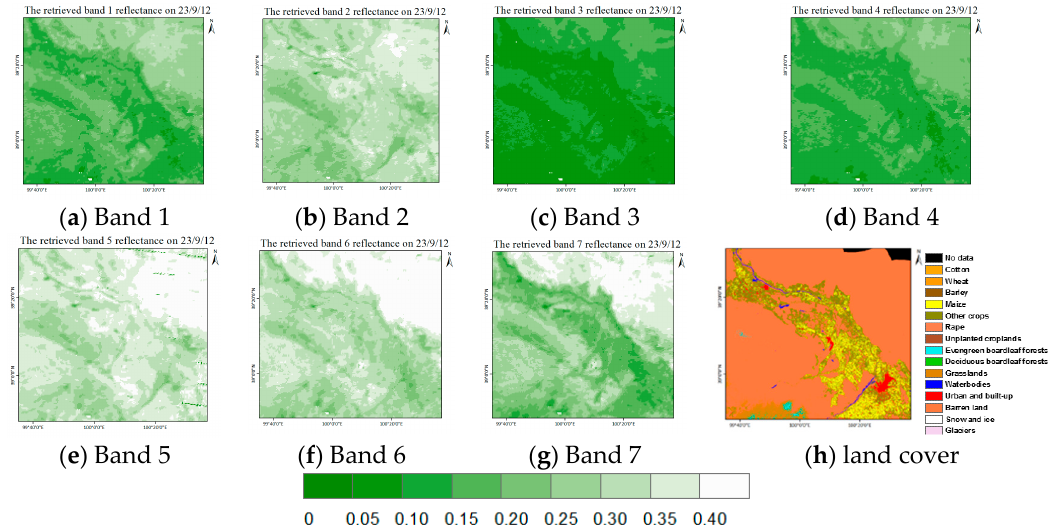
Figure 4. ( a – g ) The spatial distribution of the retrieved spectral reflectance for MODIS band 1–7 on 23 September 2012; and ( h ) the corresponding land cover data.